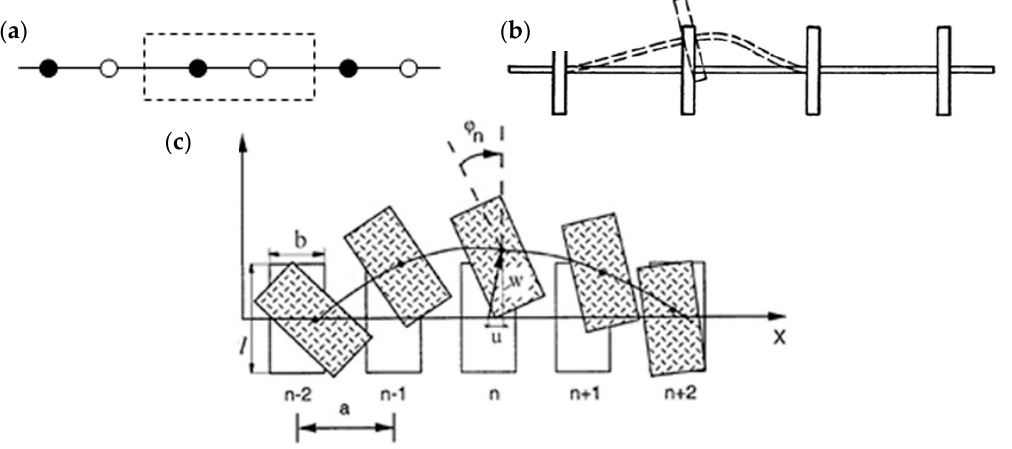
Figure 21. The models of the initiation of acoustic signals in complex environments: ( a ) model of a discrete complex structure, ( b ) Cosserat model, ( c ) model for initiating signals.